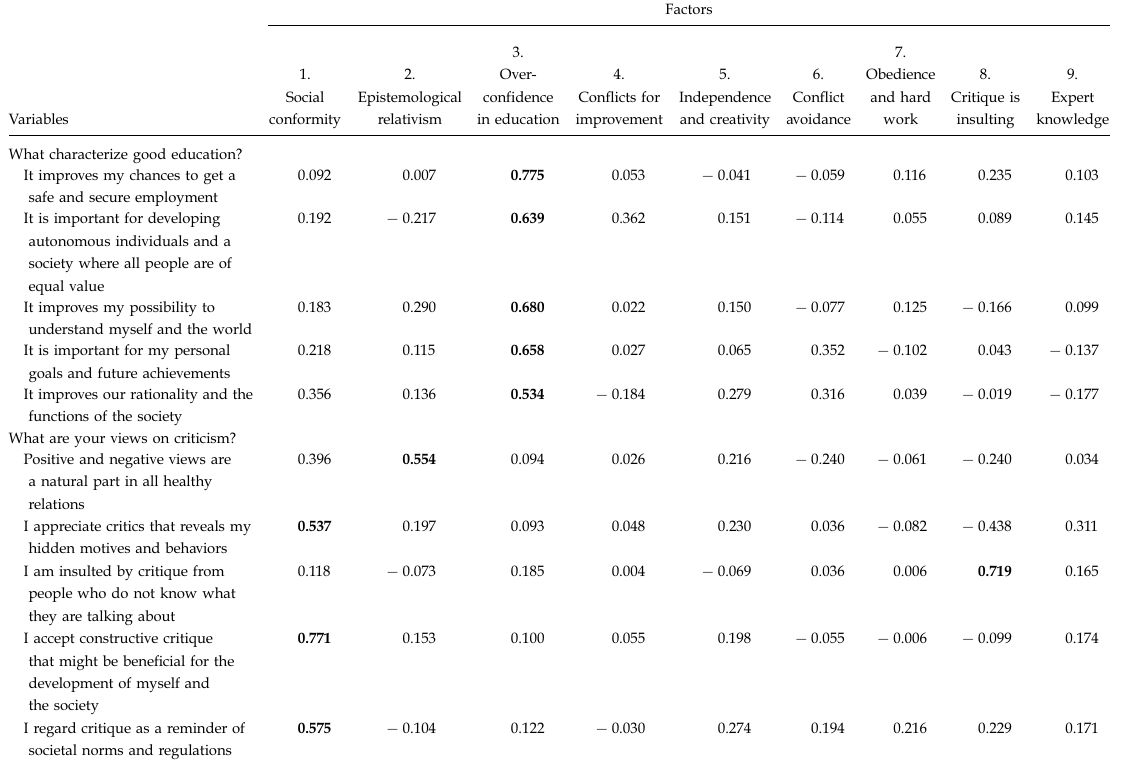
Table 1. Component matrix ( v arimax rotation) for the 30 v alue v ariables